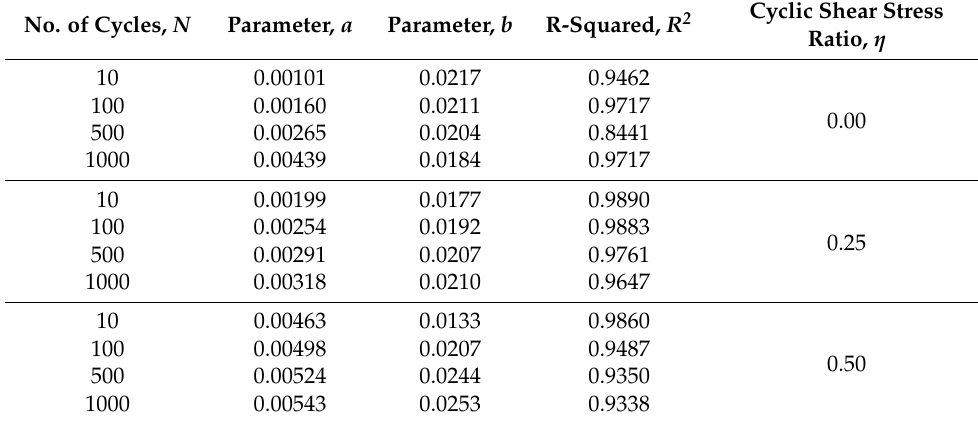
Table 4. Fitting